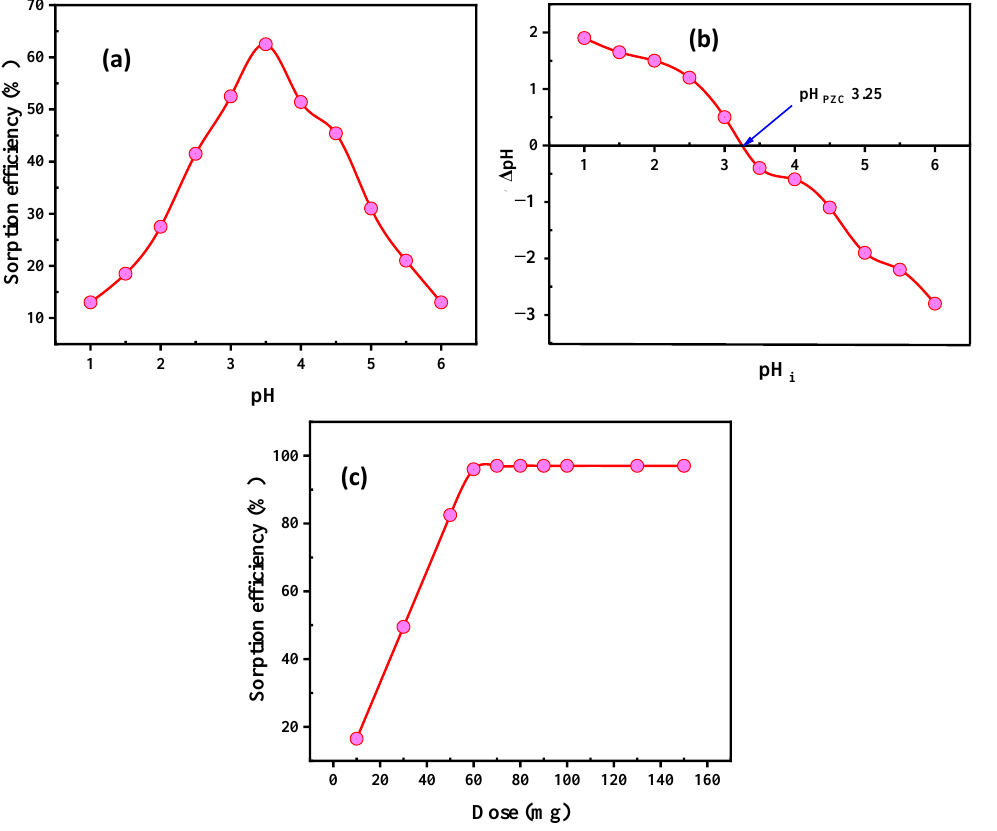
Figure 5. ( a ) Influence of pH and ( b ) SiO 2 /CS dose on the U(VI) sorption exploiting SiO 2 /CS. Figure 5. Influence of ( a ) pH, ( b ) pHi and ( c ) SiO 2 /CS dose on the U(VI) sorption exploiting SiO 2